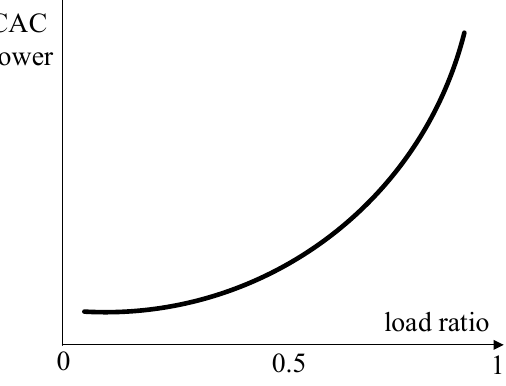
Figure 6. Relationship of CAC’s power consumptions and load ratio.